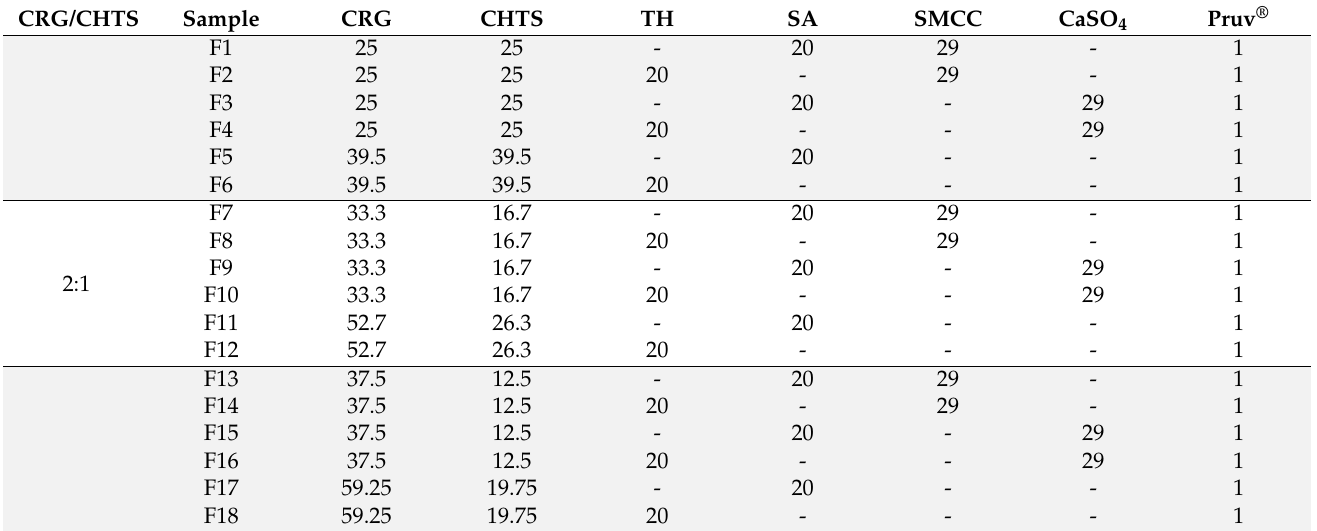
Table 1. Compositions of studied formulations (wt